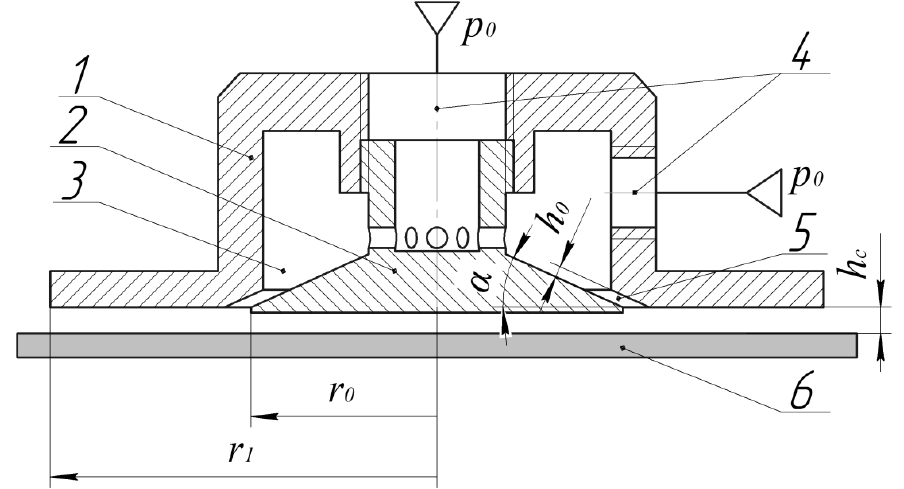
Figure 2. Constructive scheme of a Bernoulli gripping device.